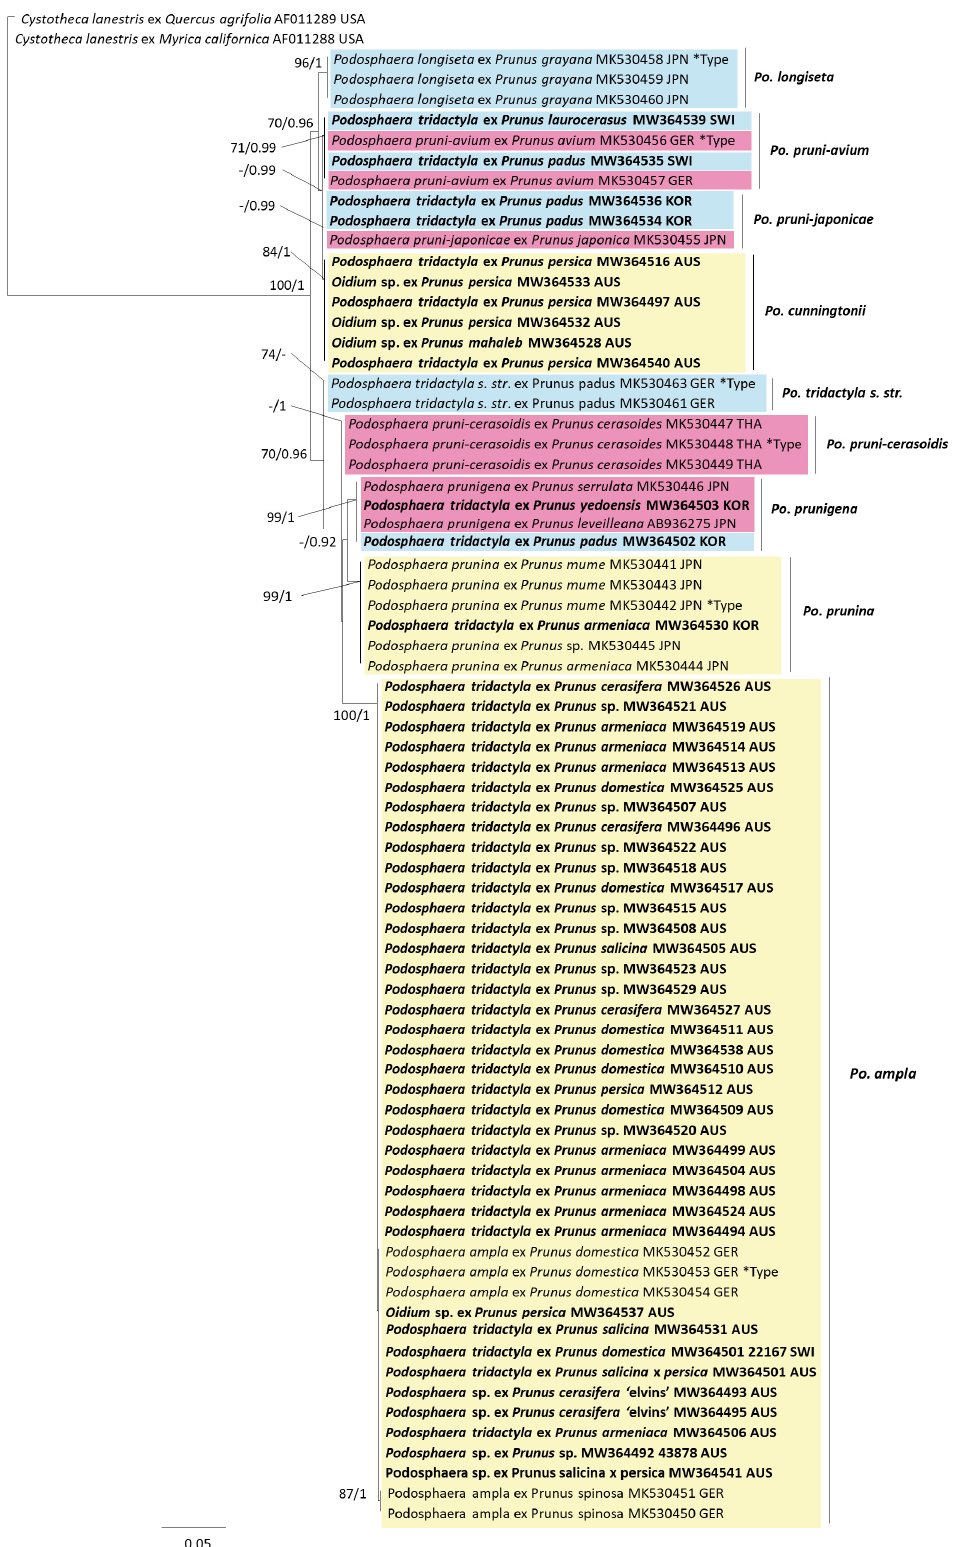
Figure 2. Maximum likelihood phylogenetic analysis of nuclear rDNA ITS1-5.8S-ITS2 and 28S sequences for the Po. tridactyla species complex and closely related species. Branch support values for maximum likelihood and Bayesian inference analyses are shown when >70% and 0.85, respectively. *Type indicates sequences obtained from isotype or holotype specimen for that species. Sequences generated in this study are shown in bold with names as originally listed in reference collections. Colours represent Prunus subgenera; Cerasus is pink, Padus is blue and Prunus is